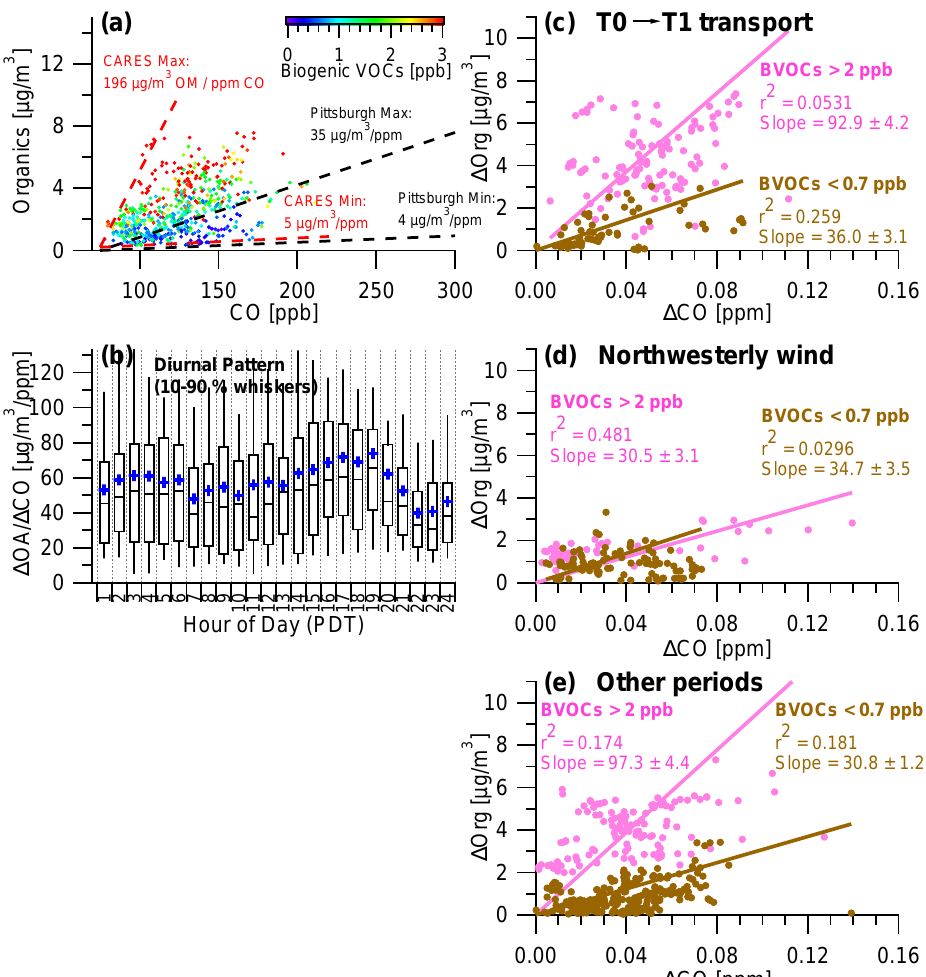
Fig. 14. (a) Scatterplot of organics vs. CO, colored by the sum of biogenic VOCs (=isoprene+monoterpenes+2-methyl-3-buten-2-ol [MBO]+methyl chavicol). (b) Diurnal pattern of 1 OA/ 1 CO. Scatterplot of 1 OA/ 1 CO during three air mass types as marked on Fig. 2: (c) T0 to T1 transport, (d) northwesterly wind and (e) other periods. In (c) , (d) , and (e) , the data points are classified into periods of high ( > 2 ppb) or low ( < 0.7ppb) mixing ratios of biogenic VOCs. Box plots: whiskers correspond to the 10th and 90th percentile, boxes to the 25th and 75th percentile, the horizontal marks in the boxes to the median, and the colored crosses to the mean. The data fitting (c, d, e) was performed using the orthogonal distance regression